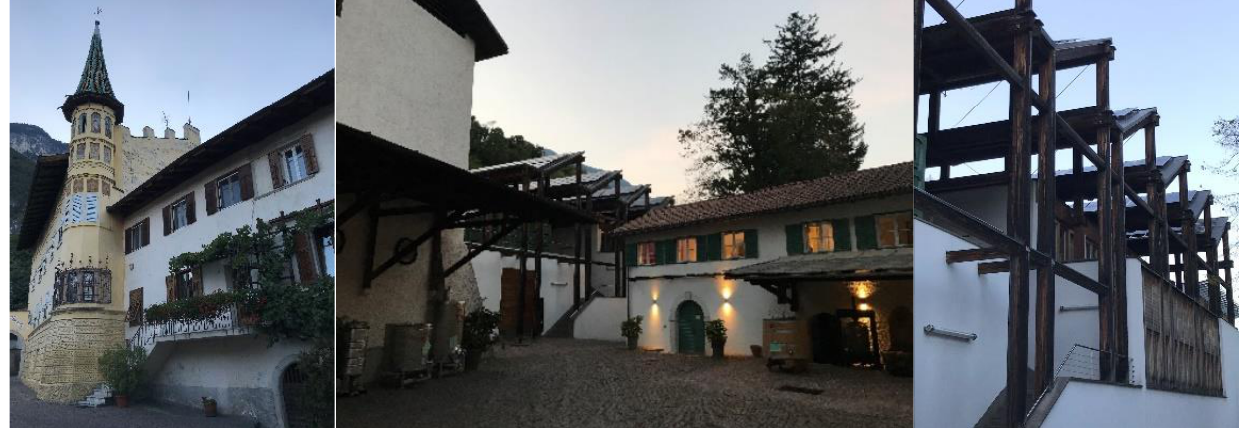
Figure 8. Positive example of the “ recognizability ” criteria on the solar roof of the Winery Alois Lageder in Magrè (Italy) thanks to the presence of traditional PV panels oriented to the maximum solar exposure (Source: Elena Lucchi).